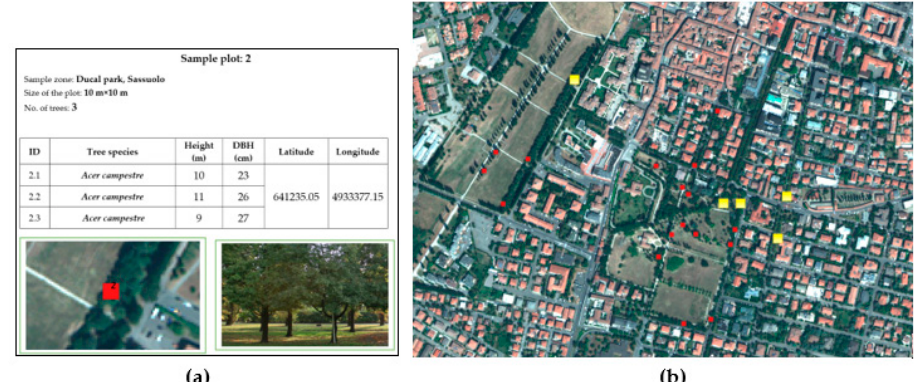
Figure 3. ( a ) One of the data sheets showing the plot position (Red square) and trees (Left) along with the required data; ( b ) sample plots (Red squares) with the validation plots (Yellow squares).